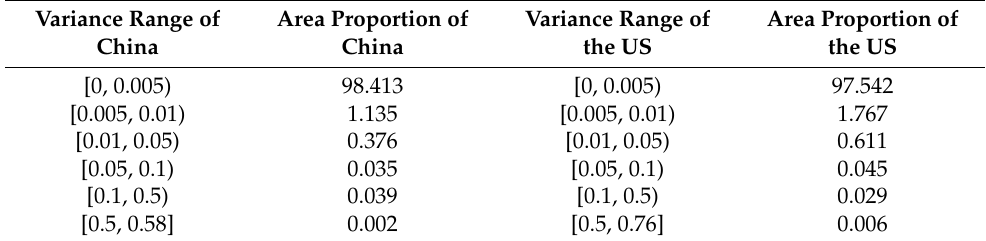
Table 1. Area proportions within different variance ranges for China and the Conterminous United States (abbreviated as “the US” in the table)